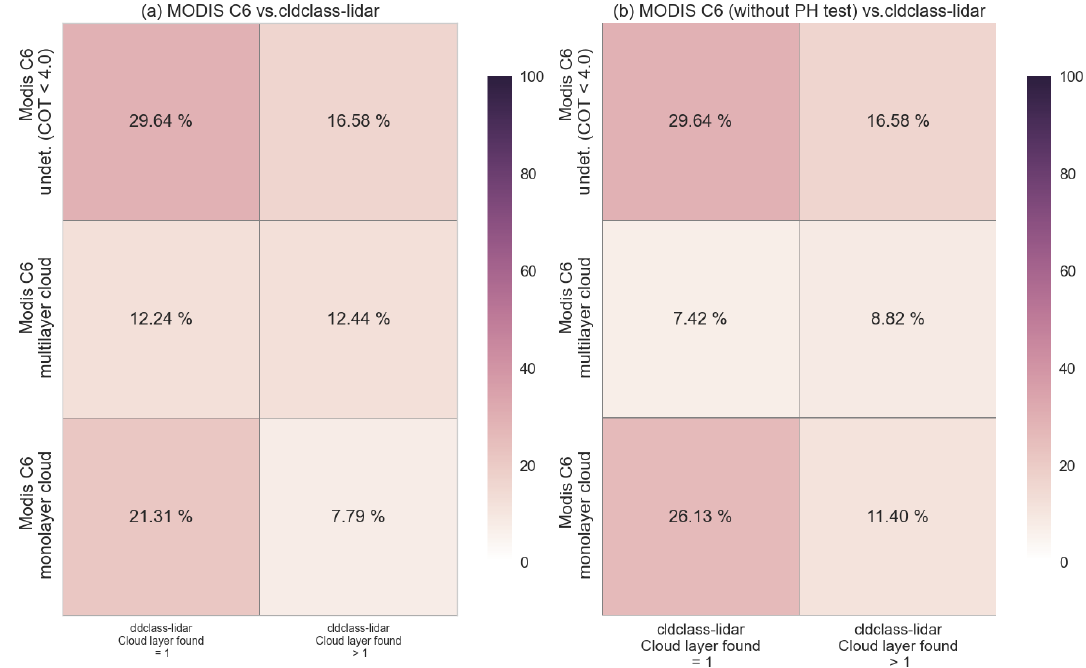
Figure 3. Contingency tables of the MYD06 C6.1 multilayer cloud detection algorithm compared against multilayer clouds defined by the 2B-CLDCLASS-lidar products: MYD06 with (a) and without (b) the Pavolonis–Heidinger (PH04) test. The 2B-CLDCLASS-lidar multilayer clouds are defined regardless of the separation distance between the cloud layers, the cloud thermodynamic phase or the COT.